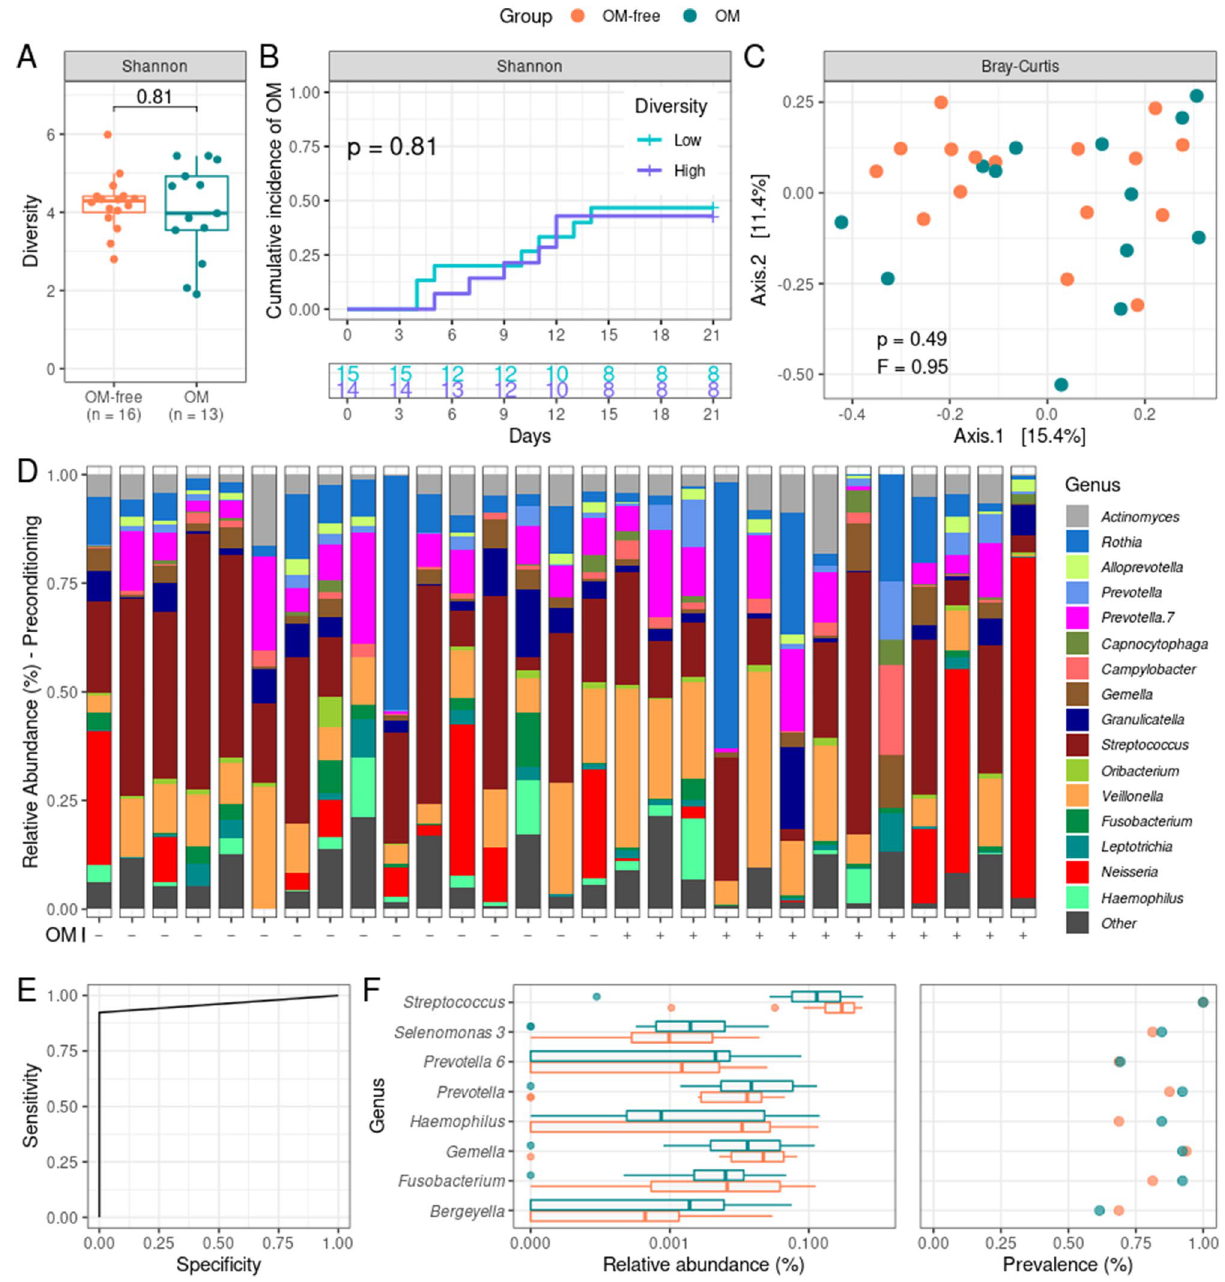
Figure 3. Comparisons between oral mucositis (OM) patients and OM-free patients at preconditioning (P). ( A ) Alpha-diversity boxplots at P for OM and OM-free patients. Shannon was used as alpha-diversity metric. Statistical significance was evaluated by the Mann–Whitney U test, with P-value indicated. The boxes highlight the median value and cover the 25th and 75th percentiles, with whiskers extending to the more extreme value within 1.5 times the length of the box. ( B ) Cumulative incidence curves of OM with patients stratified by alpha-diversity level (low/high, based on median Shannon index) at preconditioning. The number of patients at risk is shown. Statistical significance was evaluated by the log-rank test, with P-value indicated. ( C ) Principal coordinates analysis comparing compositions at P of OM and OM-free patients (beta-diversity). Bray–Curtis was used as a beta-diversity metric. Statistical significance was evaluated by the PERMANOVA test, with P- and F-values indicated. ( D ) Genera relative abundances at P for OM and OM-free patients. Patients are sorted based on OM categories (OM-free/OM: −/+), as indicated by x-axis labels. Only genera with > 1% relative abundance in > 25% of the samples or > 20% relative abundance in at least one sample are shown. ( E ) Receiver-operating characteristic curve for a support vector machine model (SVM) for classifying patients into OM and OM-free categories based on P oral microbiota data. The model was built based on the relative abundances of eight genera at P. ( F ) Relative abundances boxplots (left) and prevalence (right) for OM and OM-free patients of the eight genera at P used in the SVM model. A symlog scale was used in the x-axis of the relative abundances plot, with 10 –5 as linearity